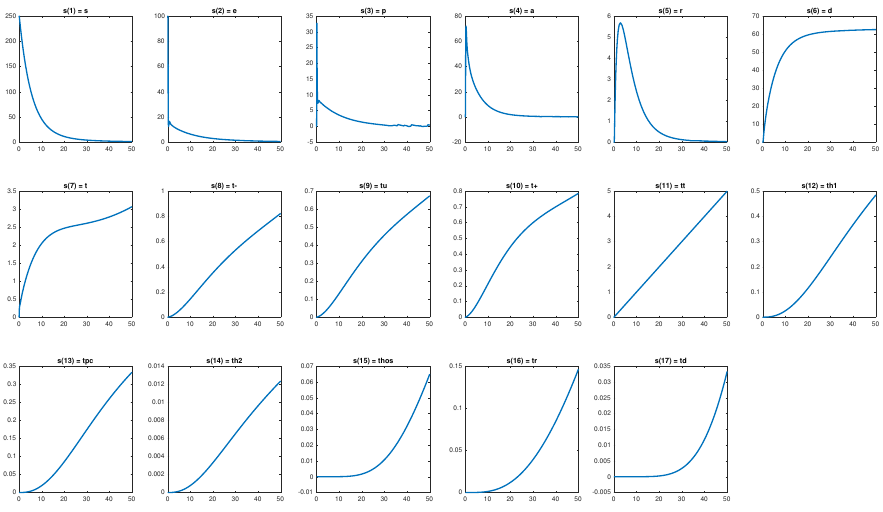
Figure 6. Evolution of the ODE with 17 infection